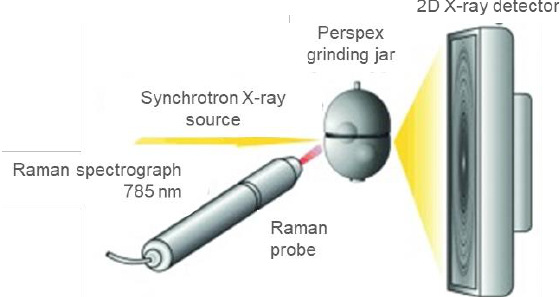
Figure 10. Schematic diagram of the experimental setup for simultaneous Raman and XRD experi- ments during mechanochemical synthesis. Reprinted with permission from [55]. Copyright 2014, John Wiley and Sons.